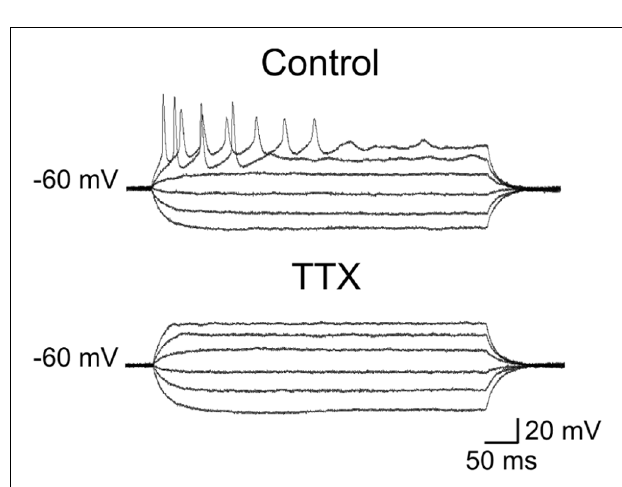
FIGURE 5 | Repetitive firing evoked in more mature granule cells. Voltage responses to depolarizing and hyperpolarizing currents steps of increasing intensity. Note clear overshooting spikes firing repetitively during depolarizing current pulses. Action potentials were readily blocked byTTX.